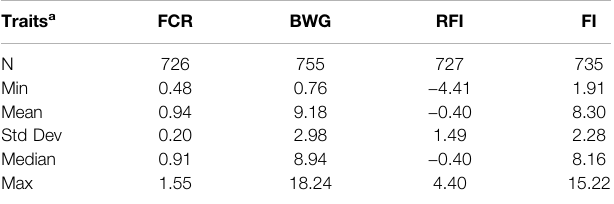
TABLE 1 | Summary statistics for all the phenotyped fi sh for each feed-ef fi ciency related trait. Traits a FCR BWG